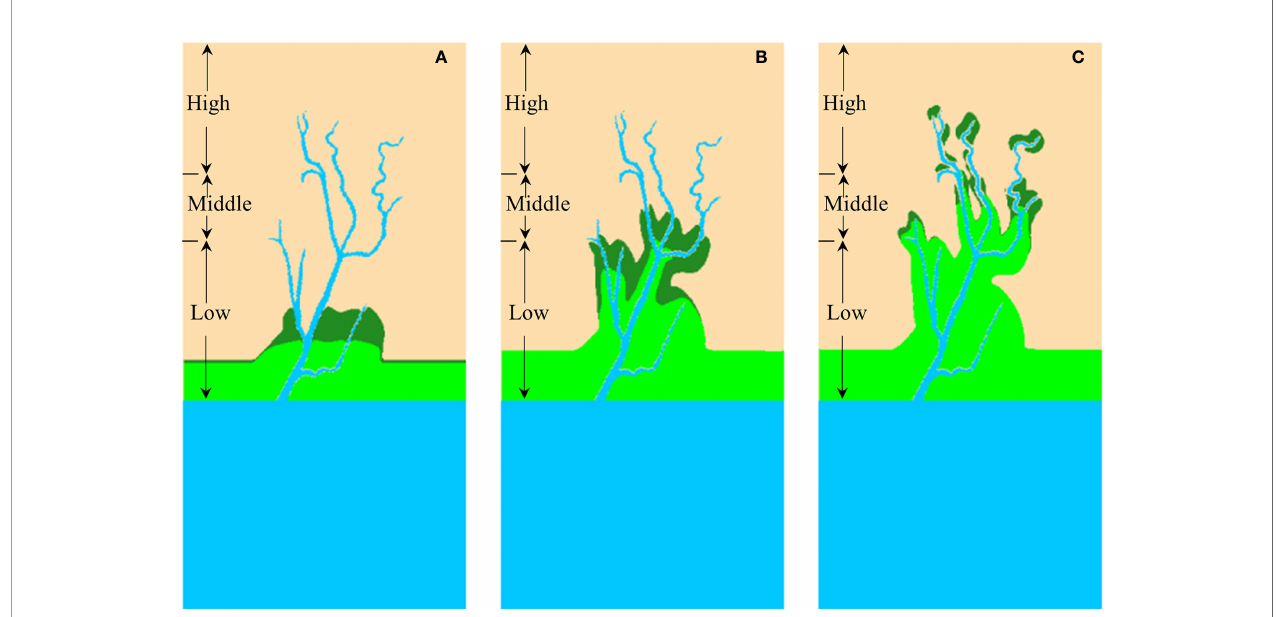
FIGURE 8 | The evolution of S. alterni fl ora landward invasion over time: (A) First year; (B) Second year; (C) Third year. The blue is tidal channel network and sea; the yellow is bare fl ats; the green is S. alterni fl ora distribution at the end of seedling season; the dark green is the added area of S. alterni fl ora between seedling stage and end of growing season. The marsh platform was divided into low, middle and high marshes based on elevation.